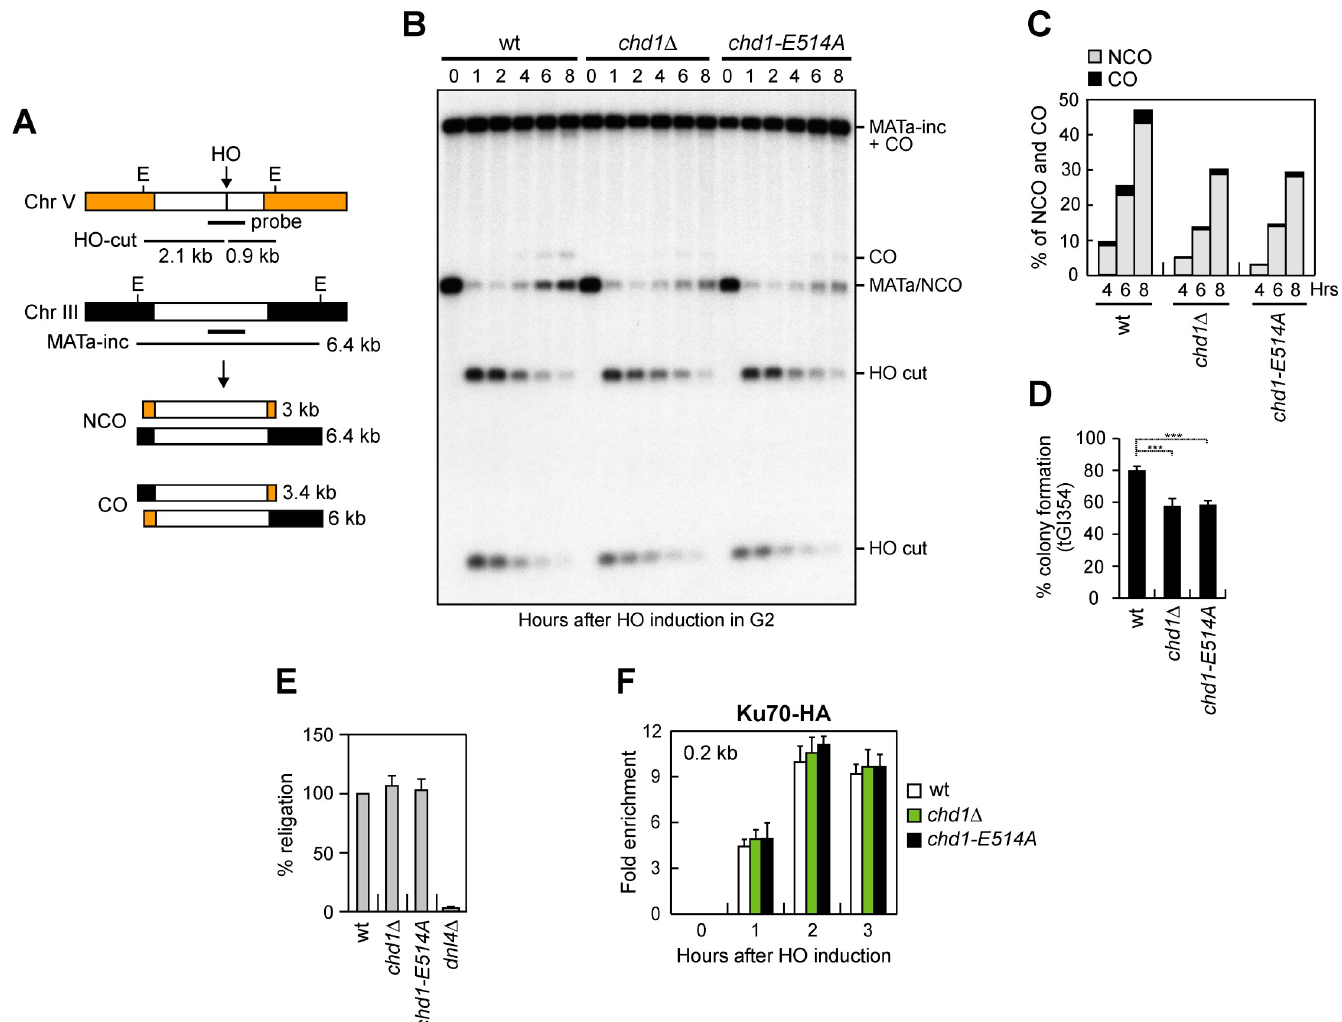
Fig 5. Chd1 dysfunction reduces DSB repair by HR. (A) System to detect ectopic recombination. HO generates a DSB at a MAT a DNA sequence inserted on chromosome V, while the homologous MAT a -inc region on chromosome III cannot be cut by HO and is used as a donor to generate noncrossover (NCO) and crossover (CO) products. E, EcoRI. (B) G2-arrested YEPR cell cultures of tGI354 derivative strains were transferred to YEPRG at time zero and were kept arrested in G2 by nocodazole. Southern blot analysis of EcoRI-digested genomic DNA with the MAT a probe depicted in panel A. (C) Densitometric analysis of CO (3.4 kb) versus NCO (3 kb) repair bands at the indicated times after HO induction. (D) Percentage of colony formation on YEPRG plates relatives to colony formation on YEPD plates. Plotted values are the mean values of three independent experiments, with error bars denoting s.d. ��� P < 0.005, t- test. (E) Plasmid re-ligation assay. Cells were transformed with the same amounts of BamHI-linearized pRS316 plasmid DNA. Data are expressed as percentage of re-ligation relative to wild type that was set up at 100% after normalization to the corresponding transformation efficiency. (F) Ku70-HA ChIP at the indicated distance from the HO-cut